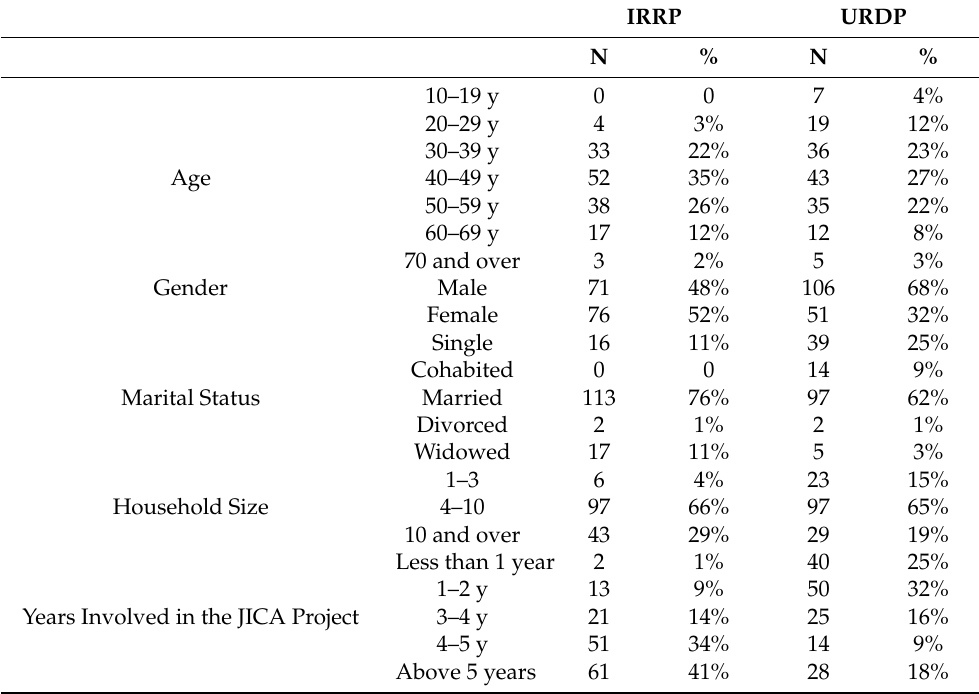
Table 1. Respondent